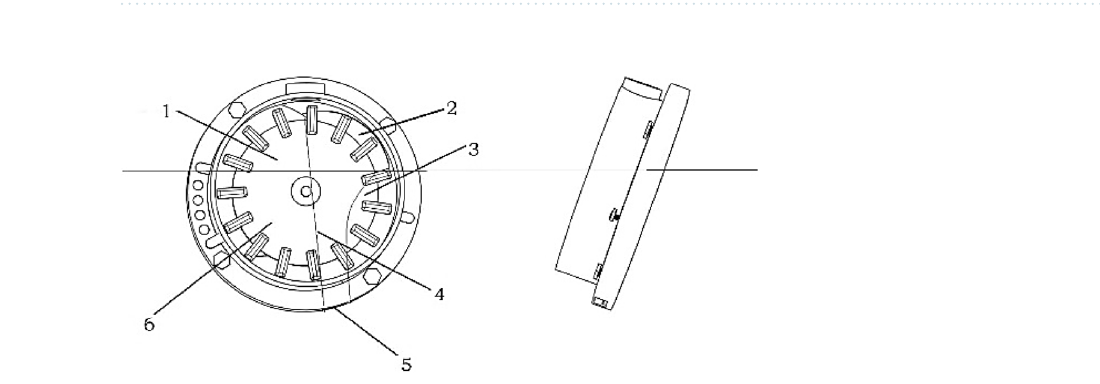
Figure 2. Structure of inclined seed-metering device.